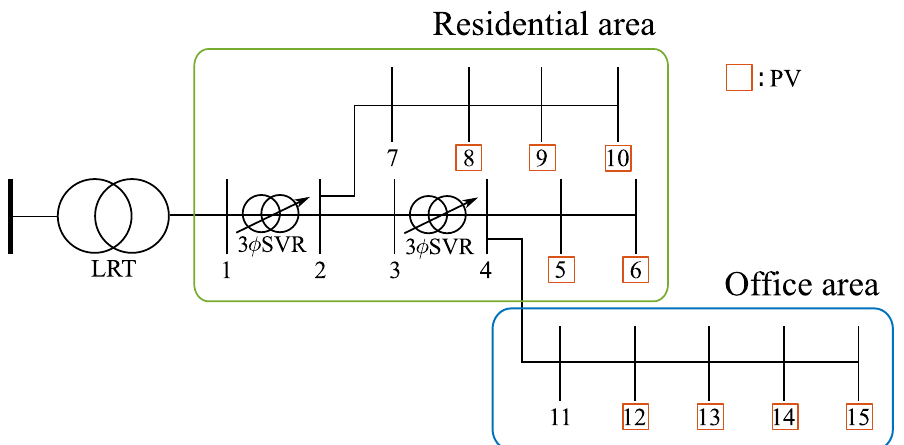
Figure 2. The configuration of the distribution system model; 3 φ SVRs are installed on line 1–2 and line 3–4.